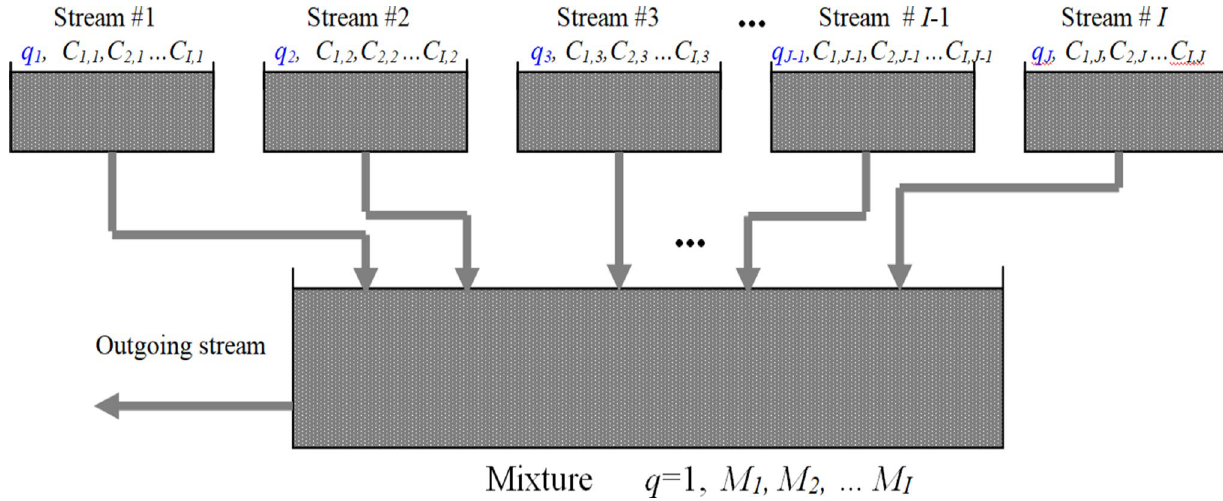
Fig. 1 Mixing diagram adopted in the physical model used by KYBL‑7